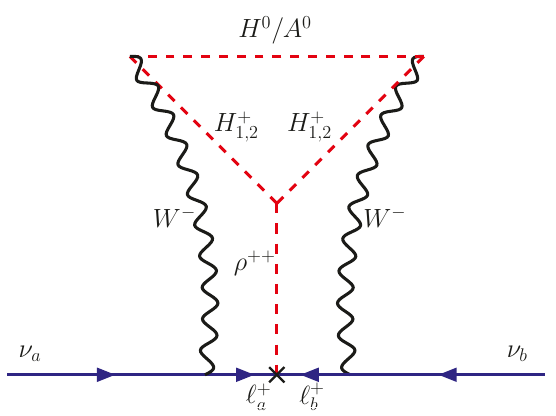
Figure 5 . The \cocktail diagram" yielding neutrino masses in the Cocktail model. BSM propaga- tors are depicted in